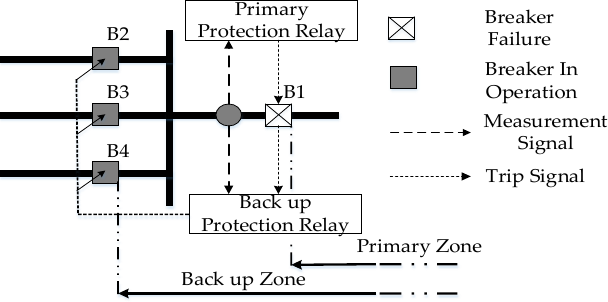
Figure 2. Backup protection strategy in event of direct current (dc) breaker malfunctioning.